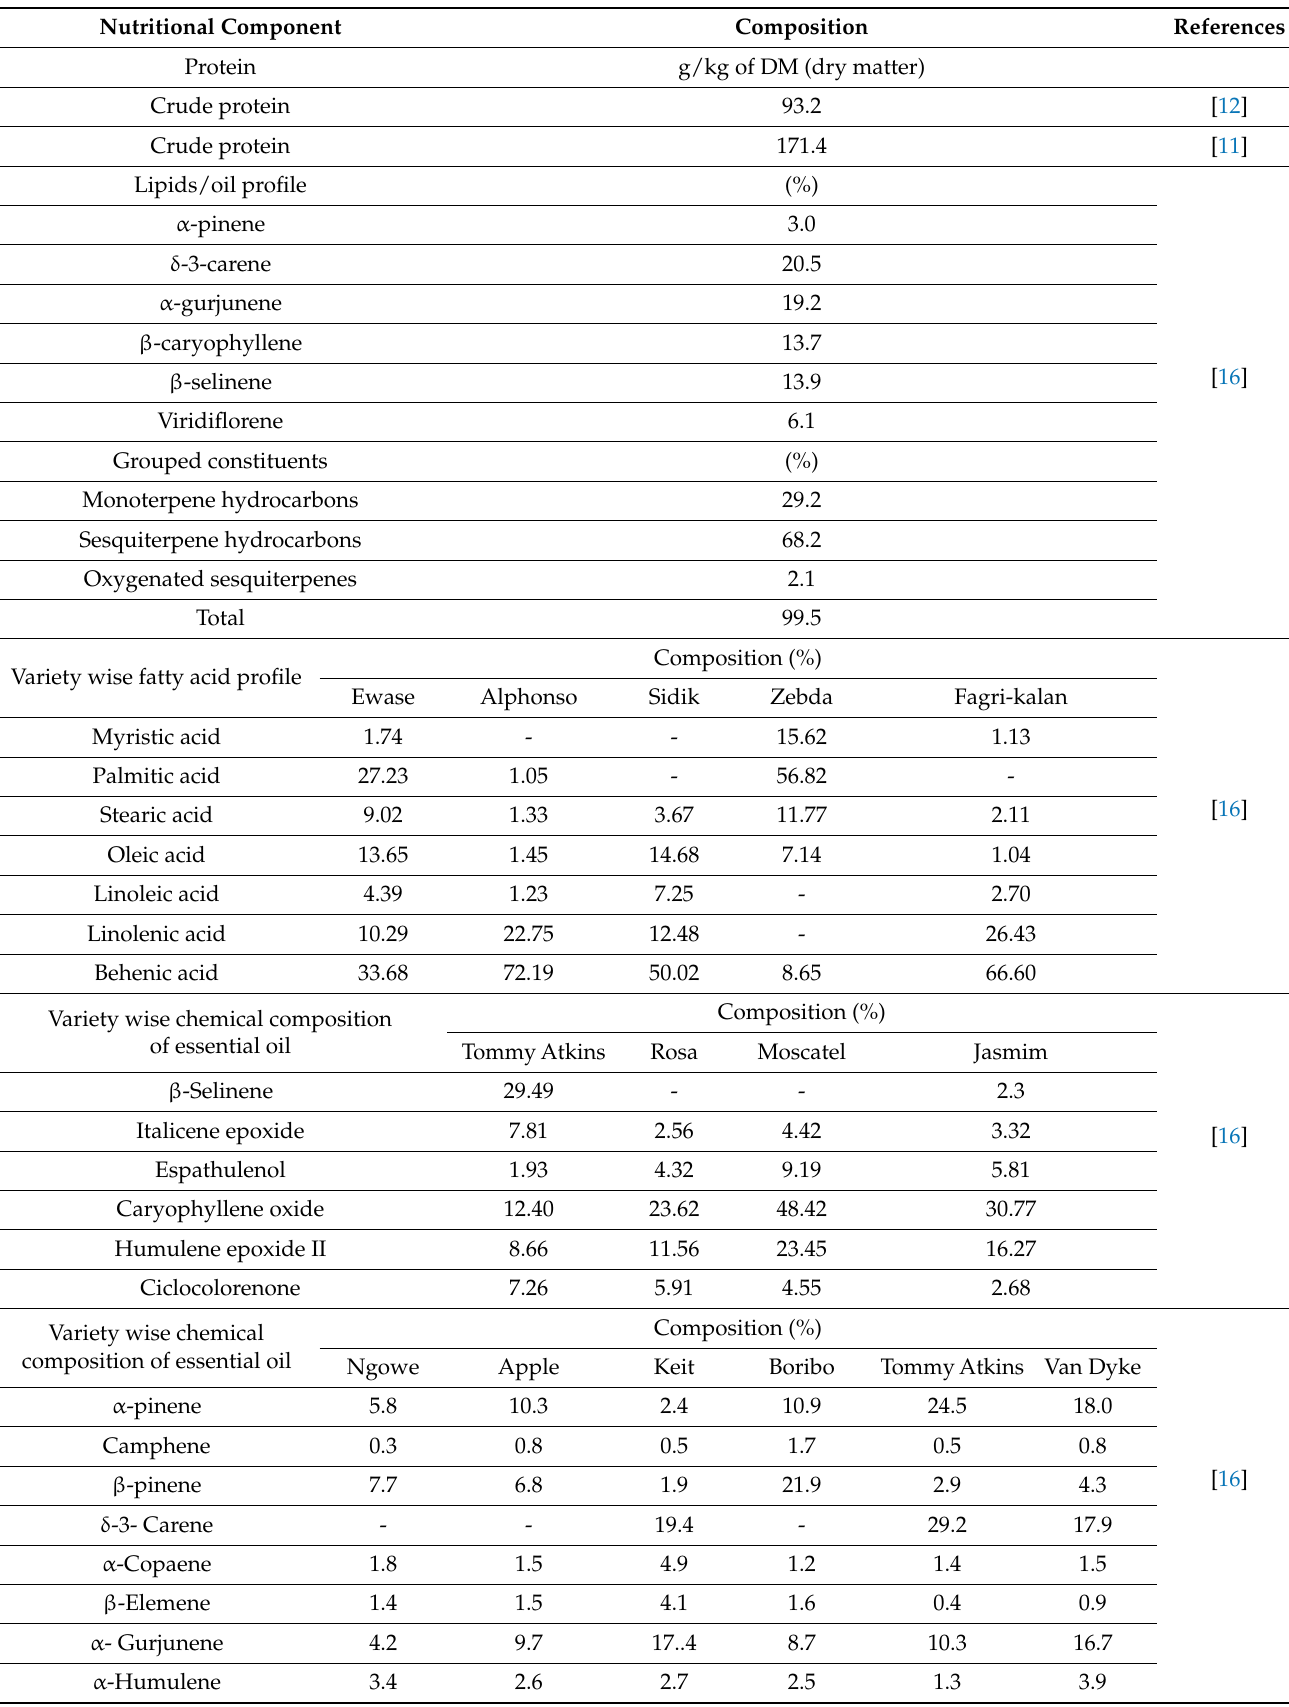
Table 1. Nutritional profile (protein and fatty acid composition) and essential oil components of mango